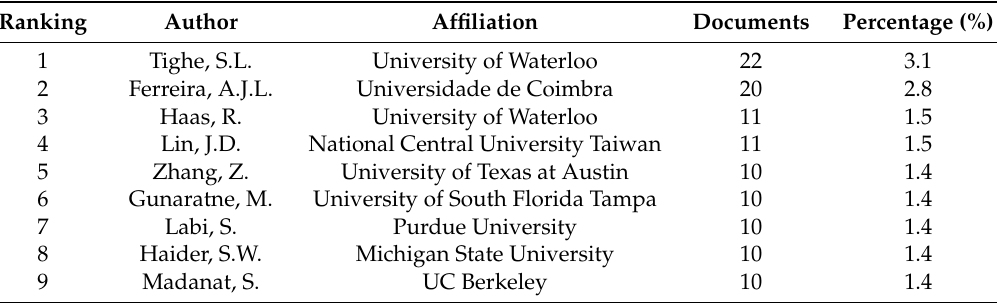
Table 4. The top nine most prolific authors.